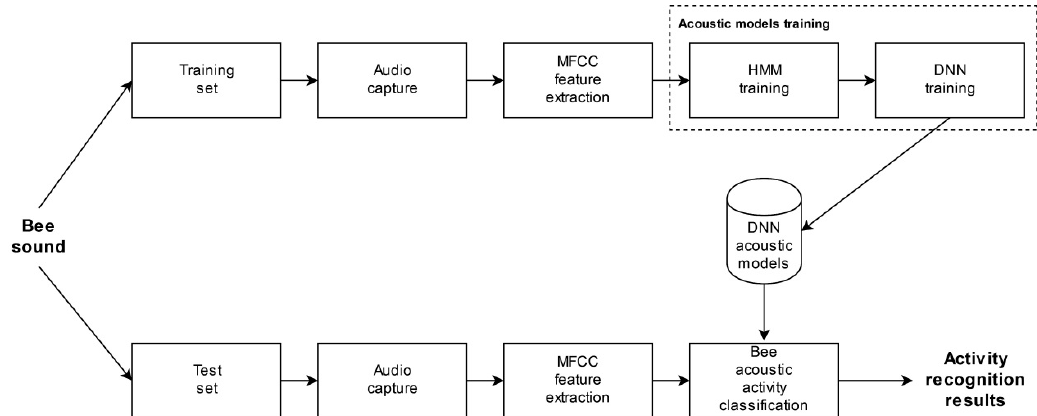
Figure 3. DNN-based bee activity acoustic classification block diagram.